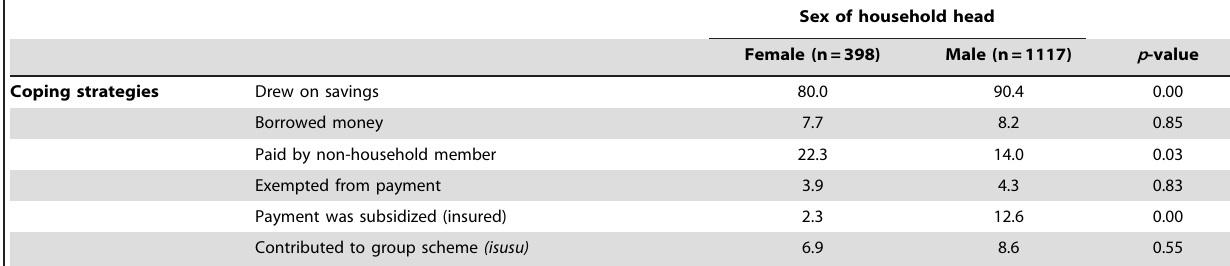
Table 4. Household coping